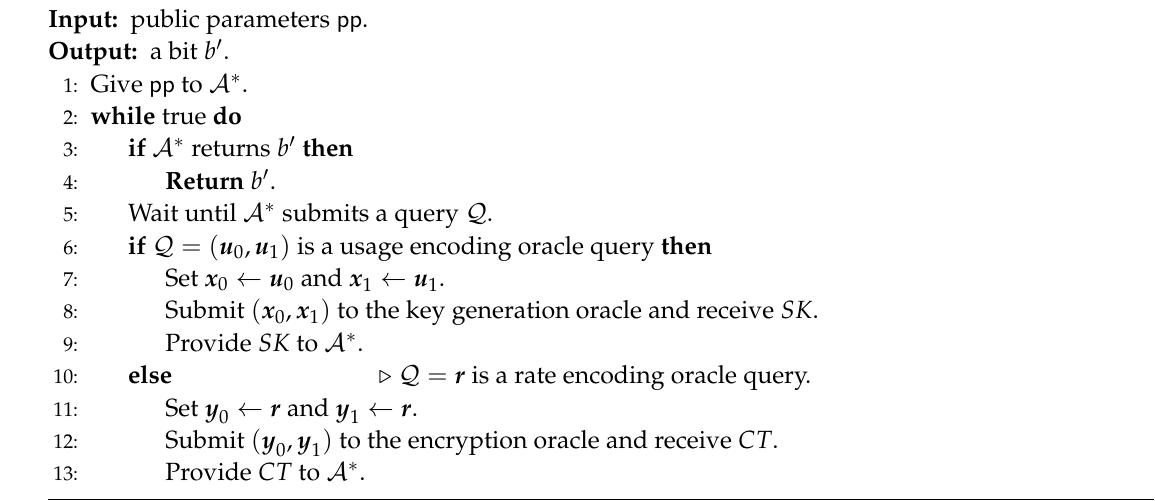
Algorithm 1 Construction of A using A